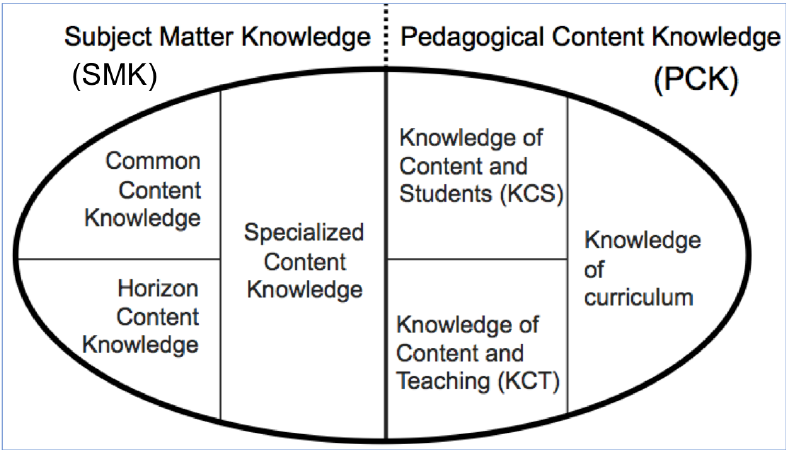
Figure 1. Dimensions of mathematical knowledge for teaching (MKT) from Hill, Ball, and Schilling